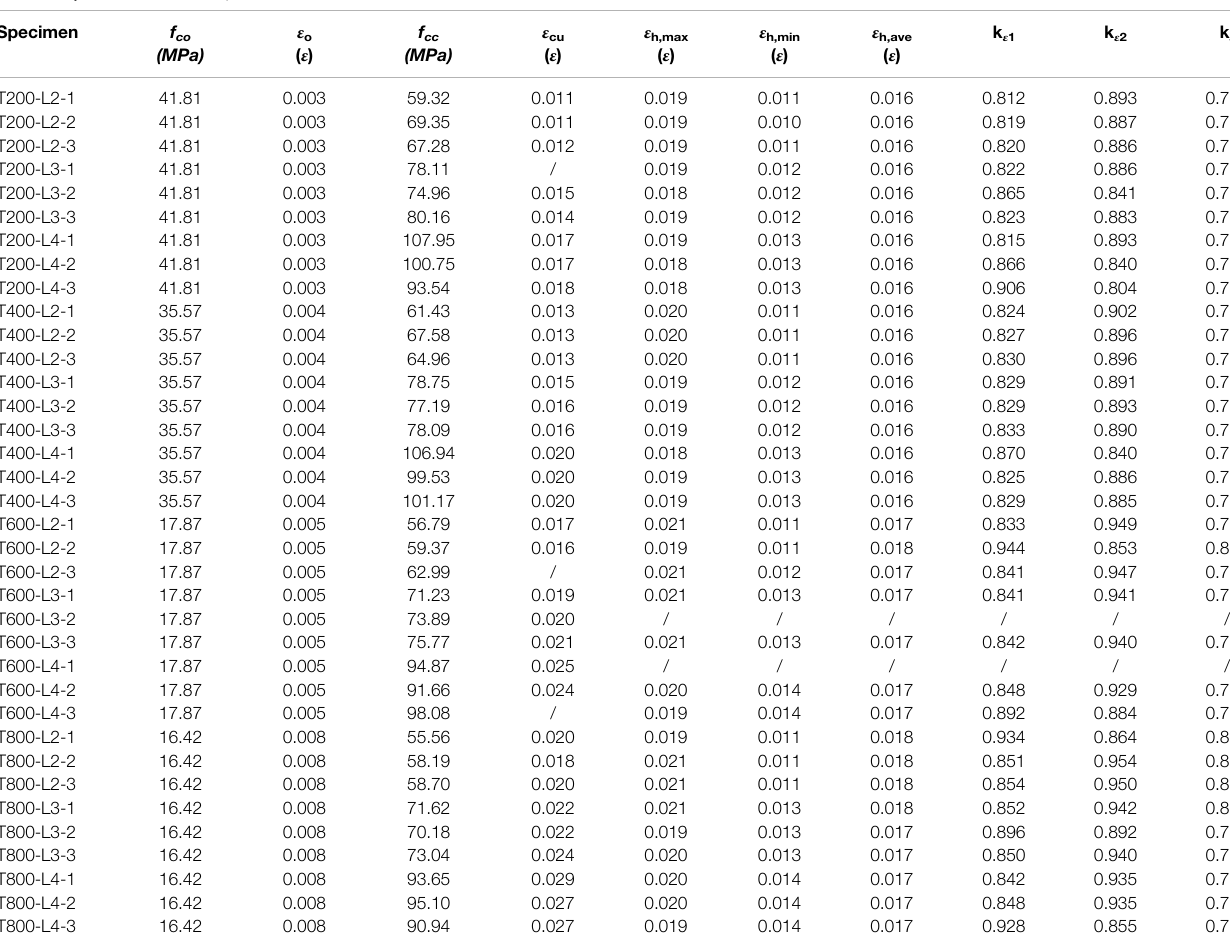
TABLE 2 | Results of the compressive tests.